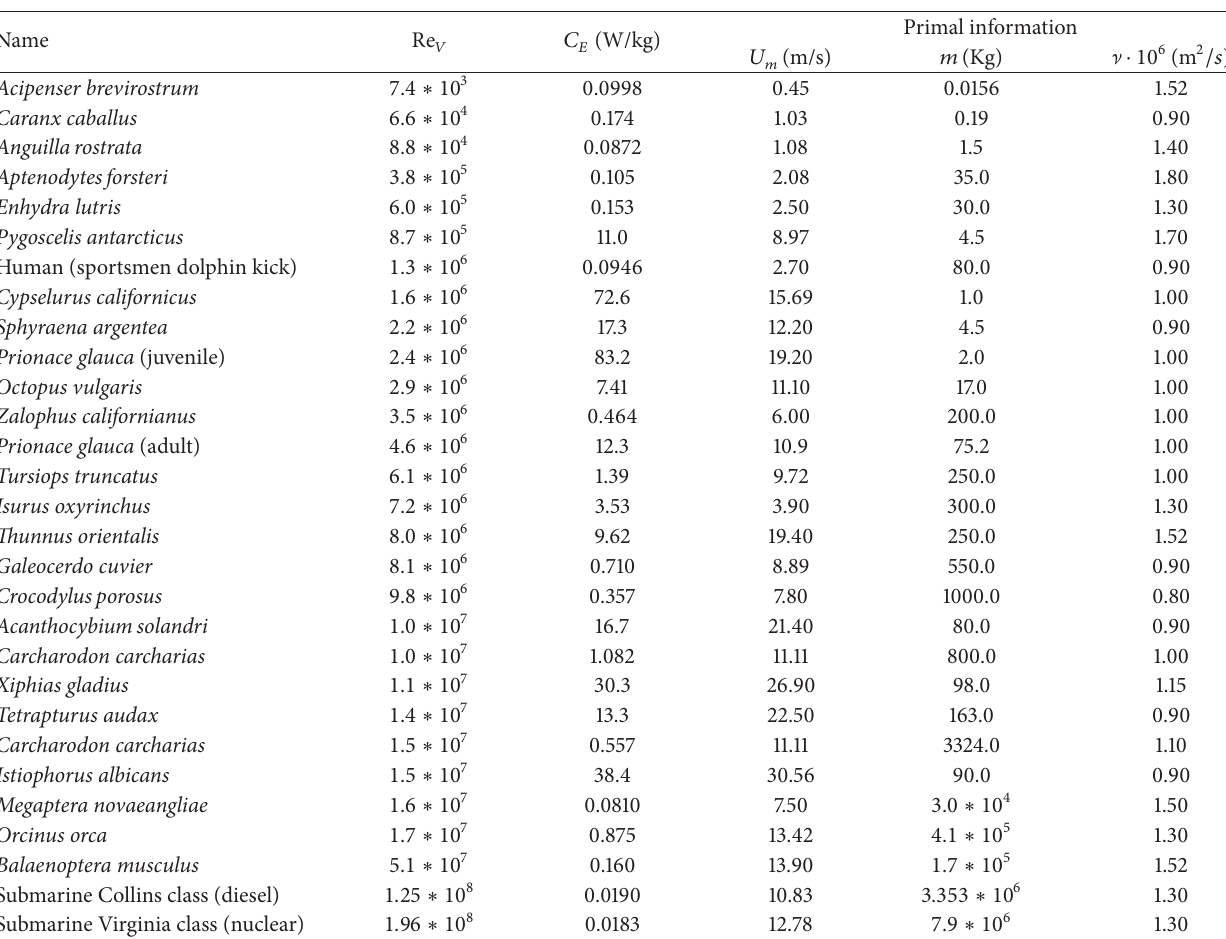
Table 2: The volumetric Reynolds number 𝑅 𝑉 and the capacity-efficiency factor 𝐶 𝐸 (W/kg) for different animals and submarines based on formula (15) and the maximum velocity, mass, and viscosity data. The following sources of the primal information were used: Dickson et al. [27] for Green jack Caranx caballus ; Deslauriers and Kieffer [28] for juvenile Shortnose sturgeon Acipenser brevirostrum ; other primal data about maximum velocity 𝑈 𝑚 , the mass 𝑚 , and the water kinematic viscosity coefficient ] is added by authors with the use of the Internet (e.g., http://www.speedofanimals.com/animals/bottlenose